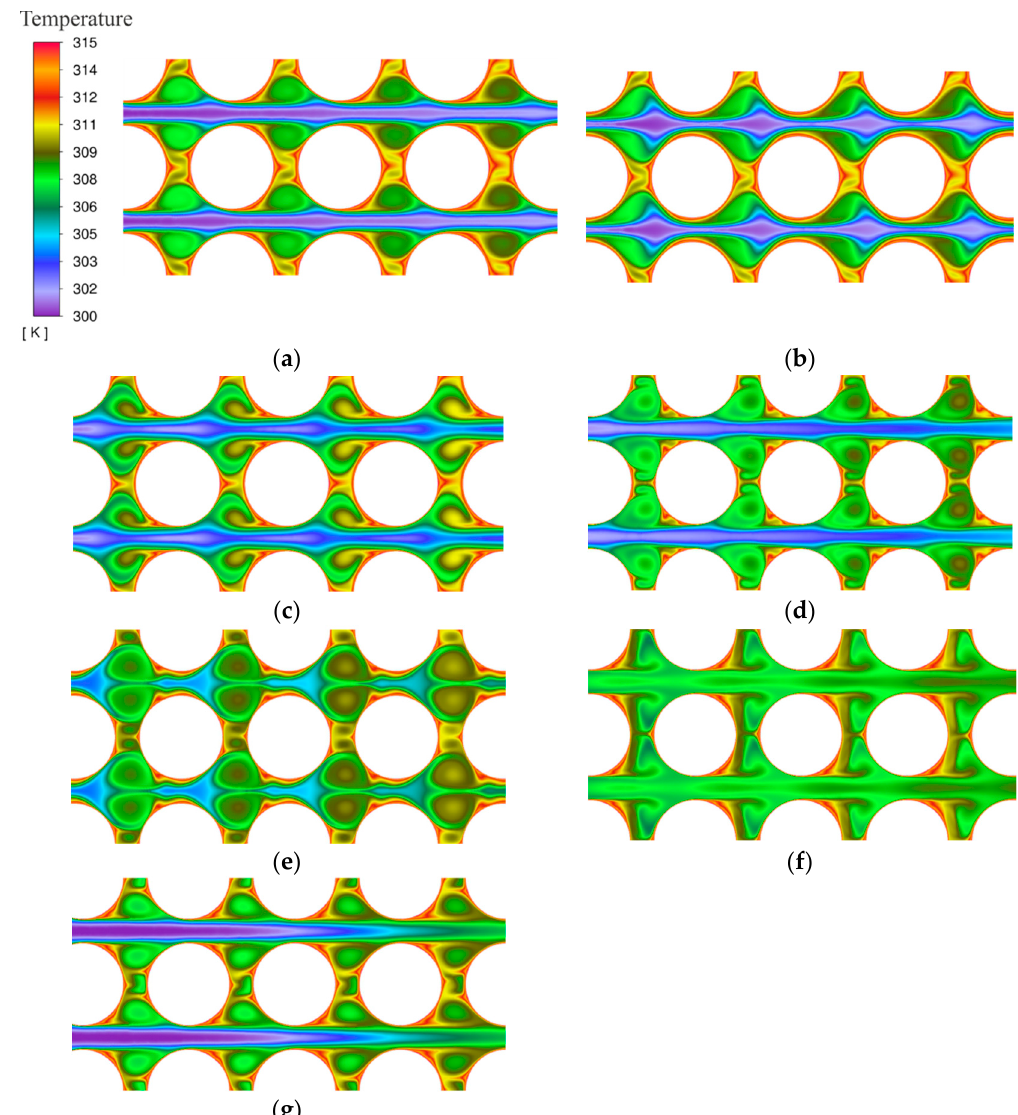
Figure 19. The instantaneous effective thermal conductivity contour plots at different phases of pul- sations for the three central rows of the tube bundle at A / D = 3, f = 0.5 Hz: ( a ) τ / T = 0.005 ( b ) τ / T = 0.025; ( c ) τ / T = 0.07; ( d ) τ / T = 0.125; ( e ) τ / T = 0.185; ( f ) τ / T = 0.32; ( g ) τ / T = 0.65.